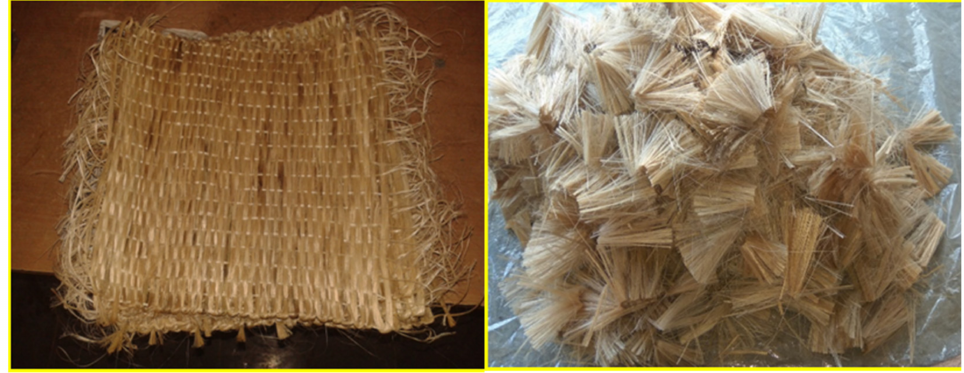
Figure 2. Banyan woven fabric and chopped neem fiber for